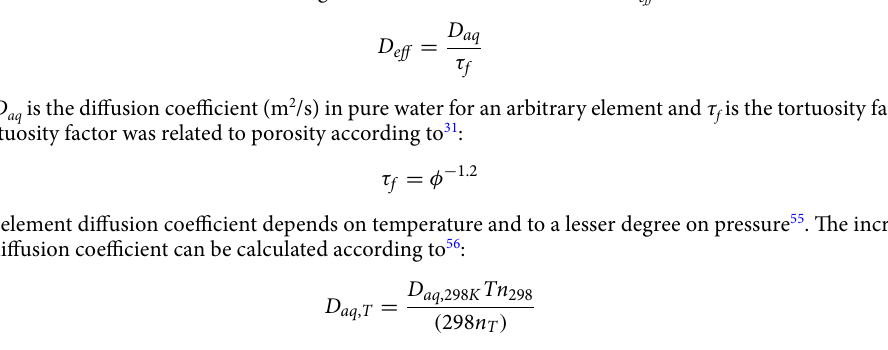
The element diffusion coefficient depends on temperature and to a lesser degree on pressure 55 . The increase in the diffusion coefficient can be calculated according to 56 :